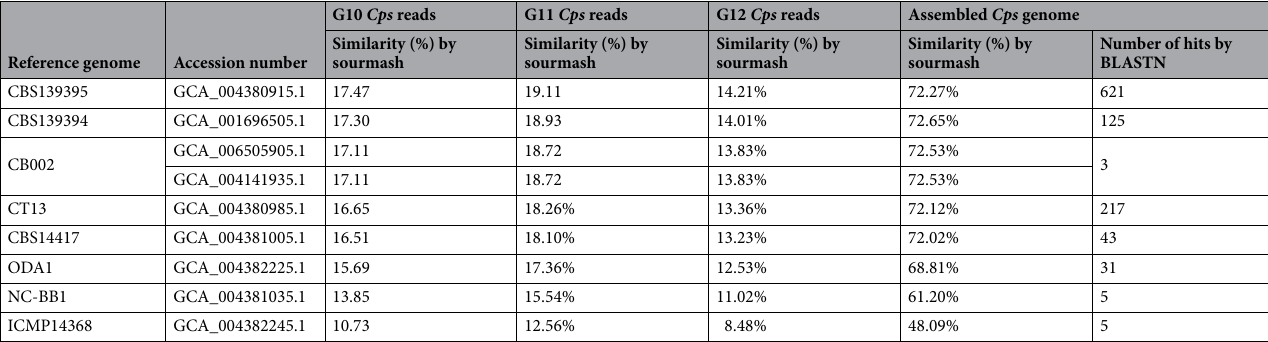
Table 3. Percentage of Cps based on Jaccard similarity obtained with sourmash and Cps hits obtained with BLASTN.